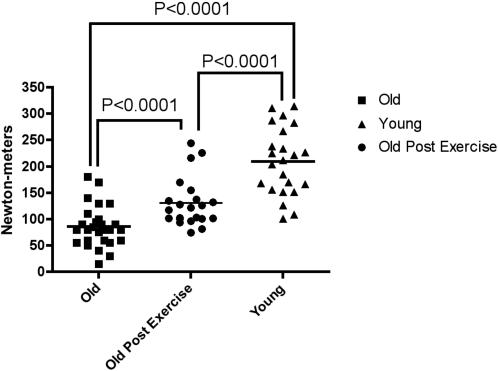
Exercise reverses a functional decline in the elderly.Each point represents an individual who underwent strength training as described in the methods. Young individuals had a greater capacity to lift the weights compared to older individuals (p<0.001, non parametric t-test). However, after 6 months training, the older individuals had a marked increase in their ability to carry out the exercise (p<0.0001, paired non-parametric t-test).